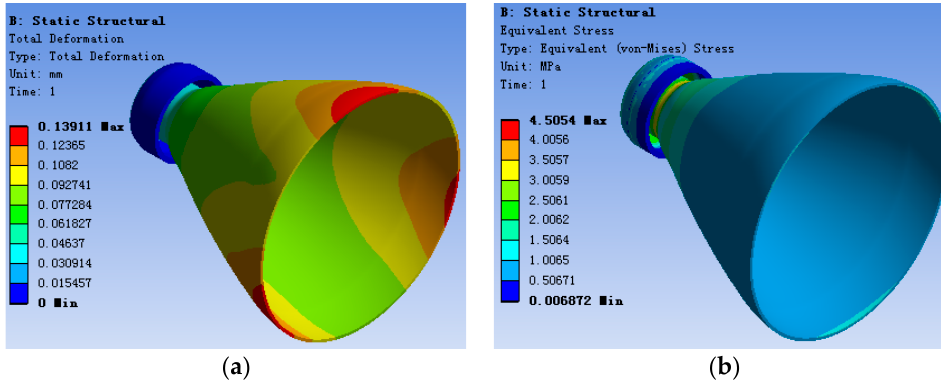
Figure 24. Cloud map of ground nozzle properties. (High altitude, 3 MPa.) ( a ) Structure Deformation. ( b ) Stress Deformation.